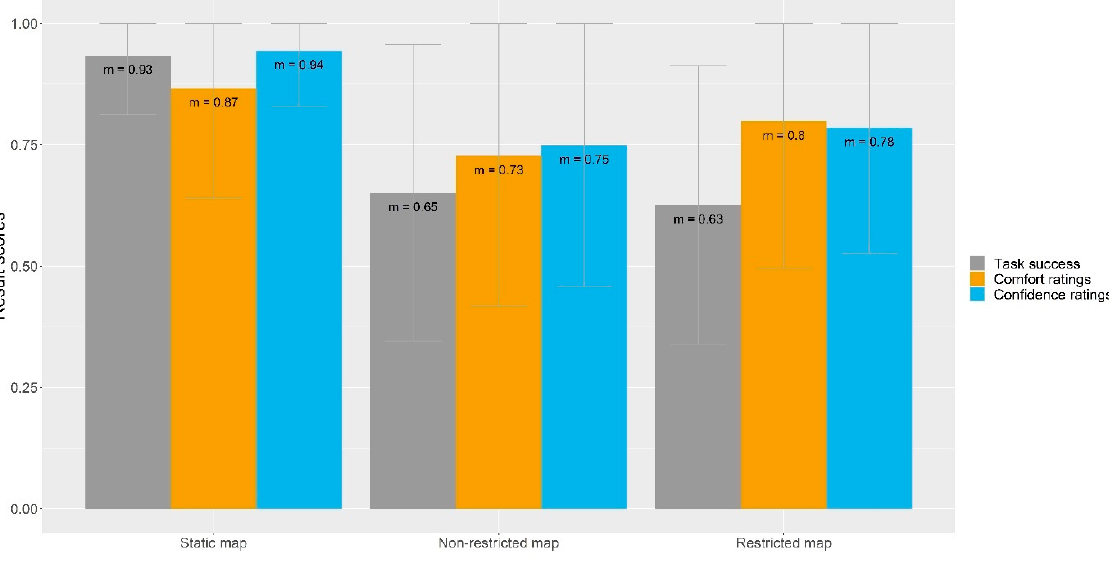
Figure 10. Task success, comfort, and confidence ratings by interactivity variant.